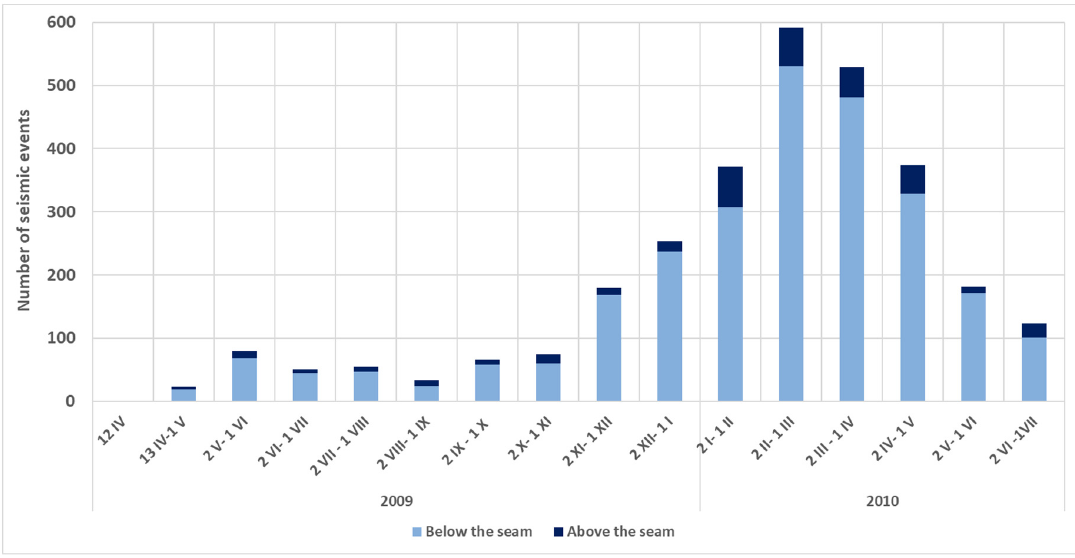
Figure 5. The number of events for each month between April 2009 and July 2010.